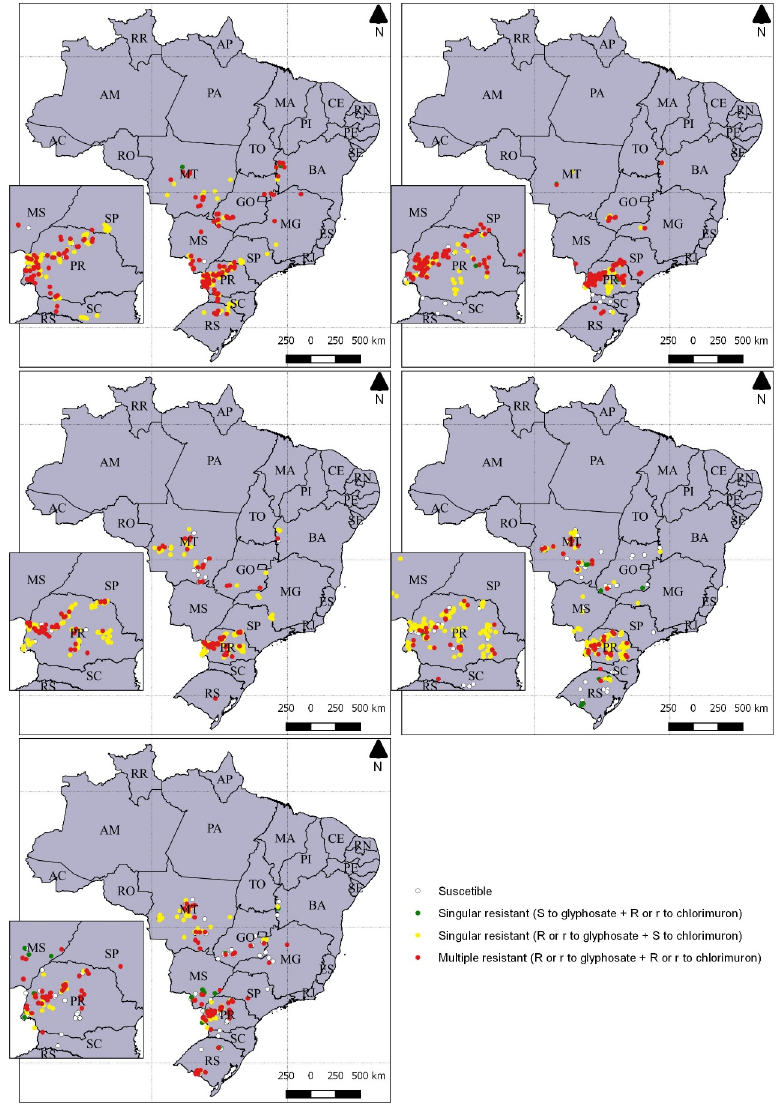
Figure 4. Distribution of Conyza spp. populations with multiple resistance to glyphosate and chlorimuron-ethyl in Brazil between 2014 and 2018. R: resistant; r: moderately resistant; S: